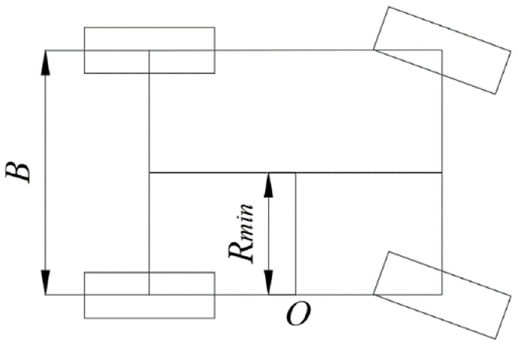
Figure 3. Schematic diagram of triangle caterpillar chassis steering of ratooning rice